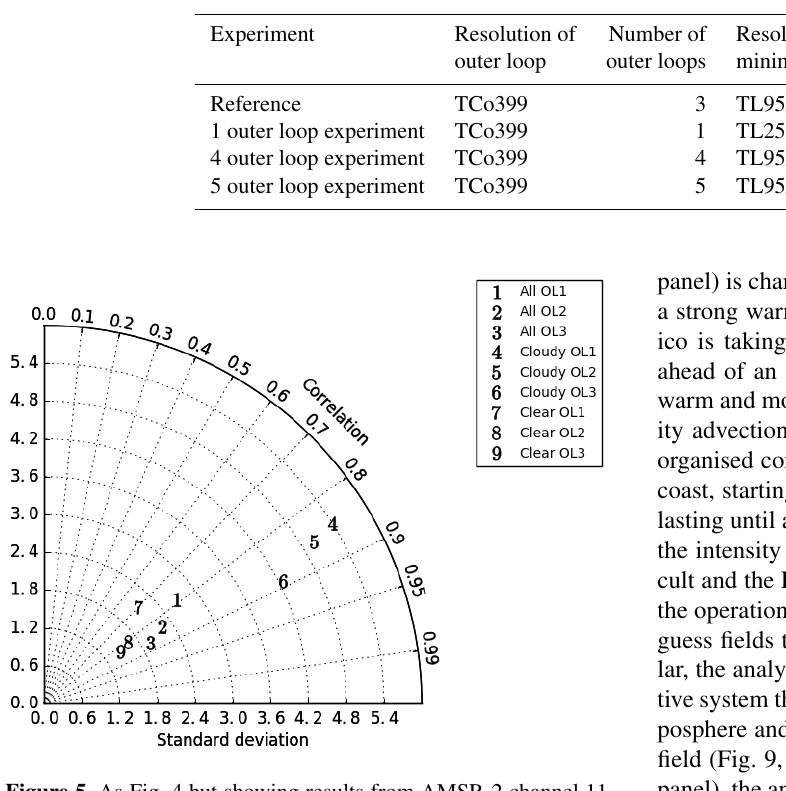
Figure 5. As Fig. 4 but showing results from AMSR-2 channel 11 categorising observations by those in clear-sky regions and those impacted by